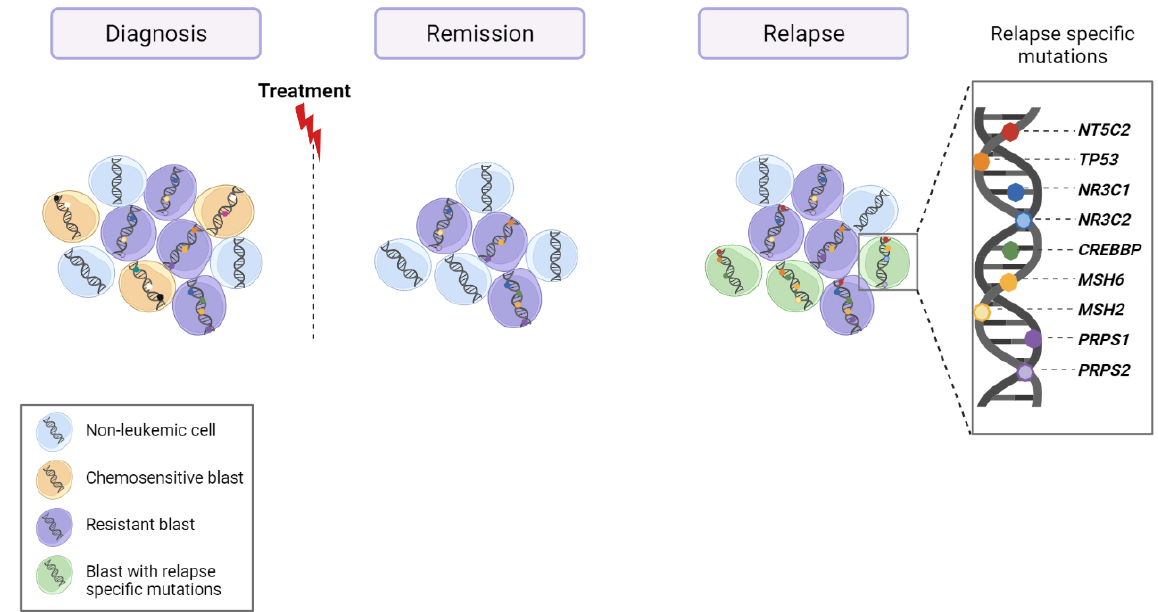
Figure 3. Schematic representation of clonal evolution of leukemic cells from diagnosis to relapse. As described above, relapse blasts contain genetic mutations present at diagnosis and genetic mutations relapse’ specific. The most prevalent relapse-specific mutations are shown at the right side of the picture.